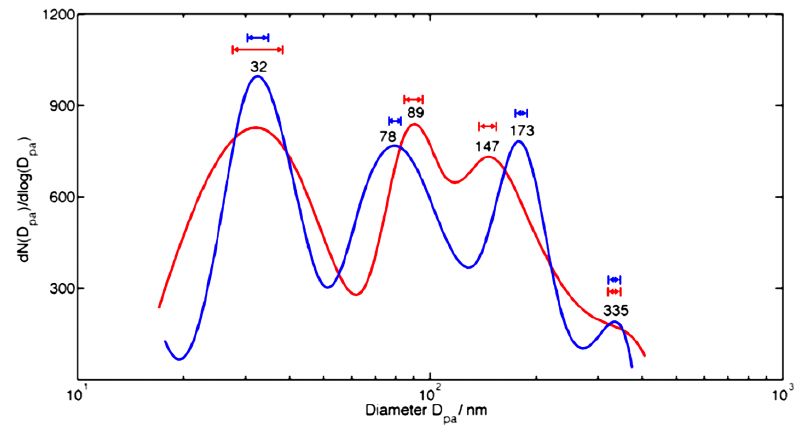
Figure 3. Number size distribution of the total aerosol collected for this study with the red line representing the SEM-derived particle number distribution, and the red error bars representing the error in size determination retrieved from calibration measurements described in Hamacher-Barth et al. (2013). The blue line depicts the number size distribution from simultaneous Tandem Differential Mobility Particle Sizer measurements, and the blue error bars depict a 5% uncertainty of the data (Wiedensohler et al., 2012).